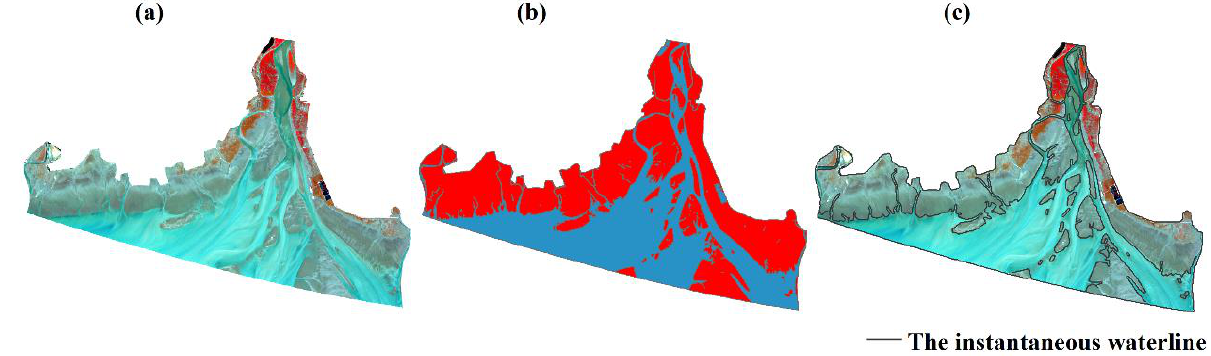
Figure 2. Sketch of the instantaneous waterline inverted by remote sensing images. (( a ): The false color image, ( b ): Classification map, and ( c ): Waterline overlay image.).